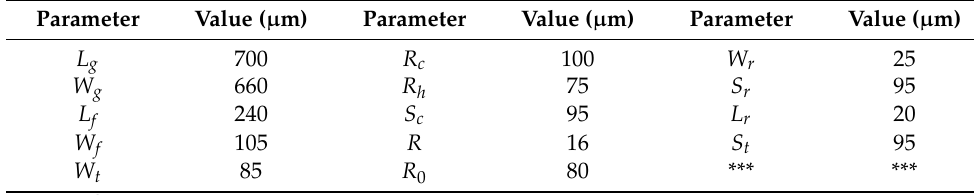
Table 1. Design Parameters of the THz